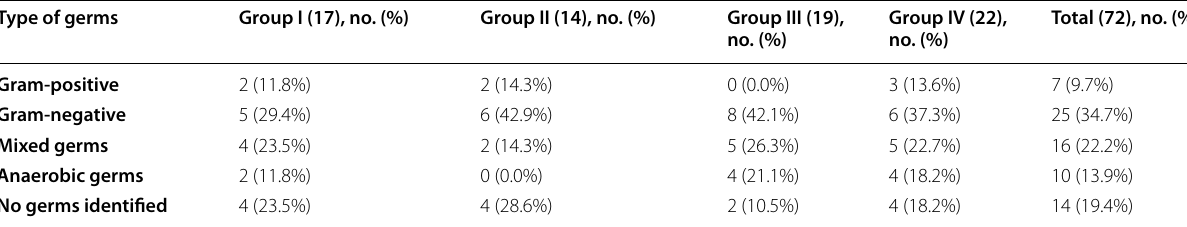
Table 2 Bacteriological results of pleural effusions in different sonographic groups